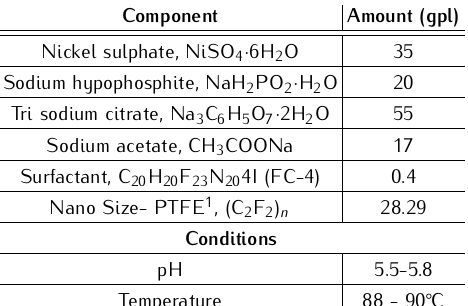
Table 1. Composition and Operating Conditions of Ni-P and Ni-P- PTFE Coating